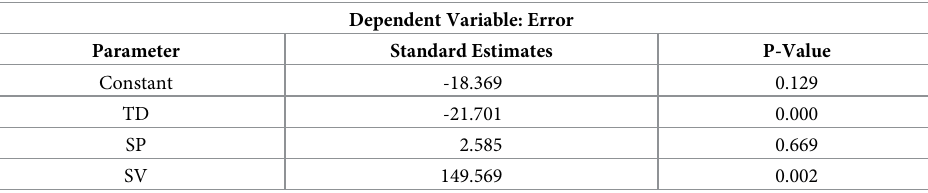
Table 8. Statistical error analysis for heterogeneous 3D